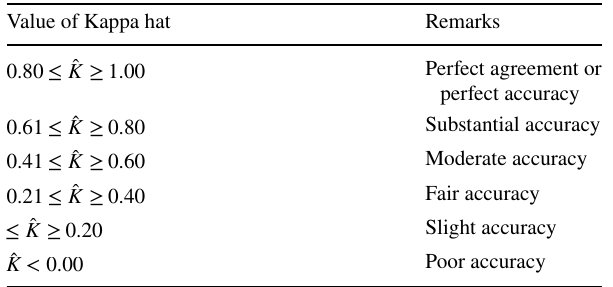
Table 2 Kappa coefficient and accuracy remarks. Source : Bogoli- ubova and Tymków (2014)